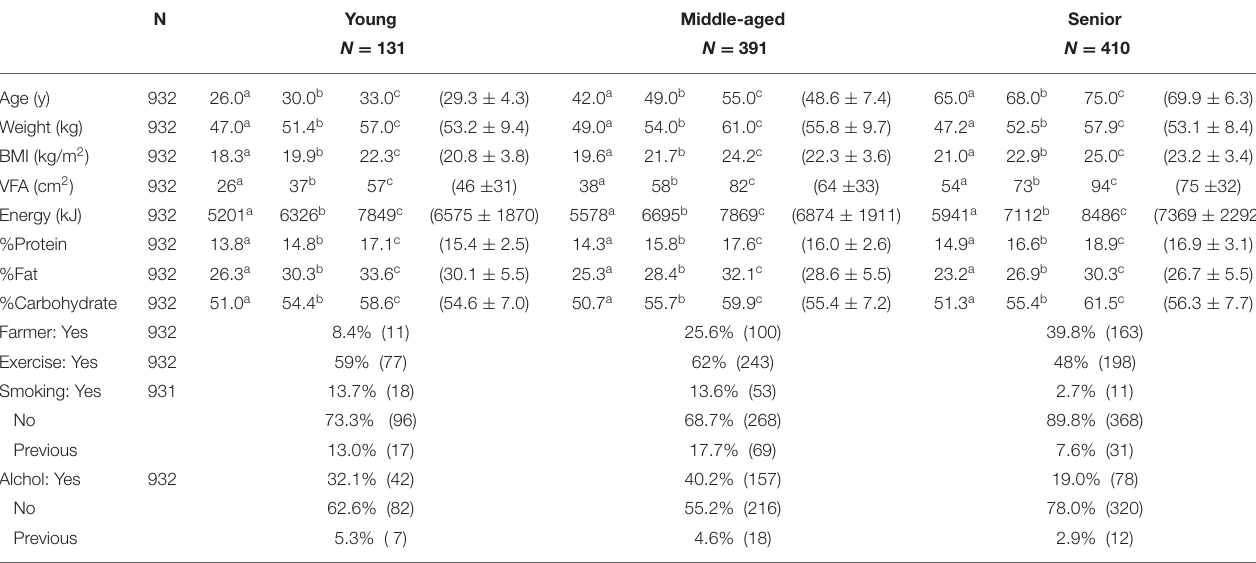
TABLE 1 | Background descriptive statistics by age-group in female